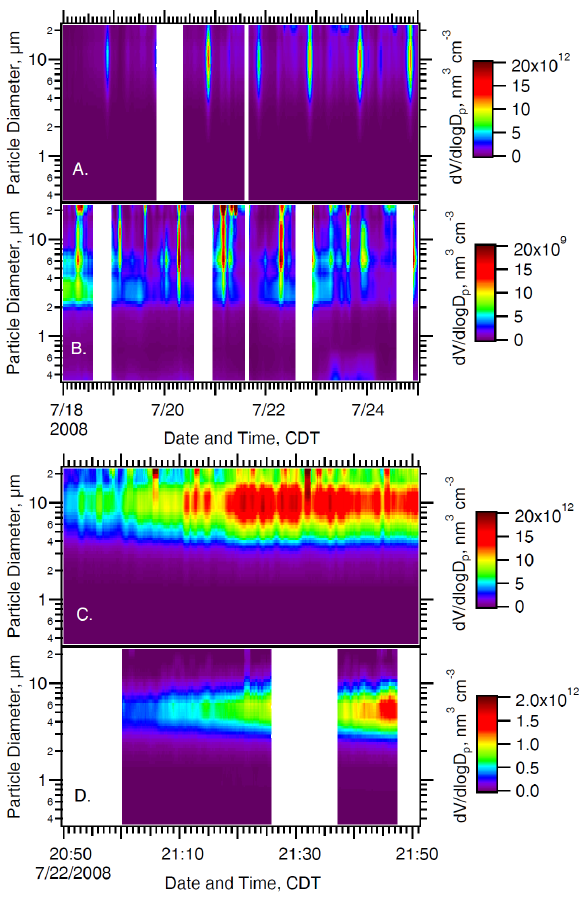
Fig. 5. Hourly averaged aerosol volume distributions measured at the upwind and downwind locations are shown in (A) and (B) , re- spectively. An expanded view of 1h of data collected on 22 July from the downwind site is shown in (C) , and data collected at the far-field location in the same time period is shown in (D)